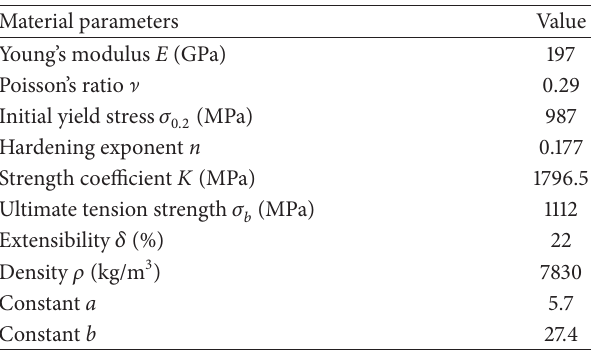
Table 1: Material properties of 2169 stainless steel tube.